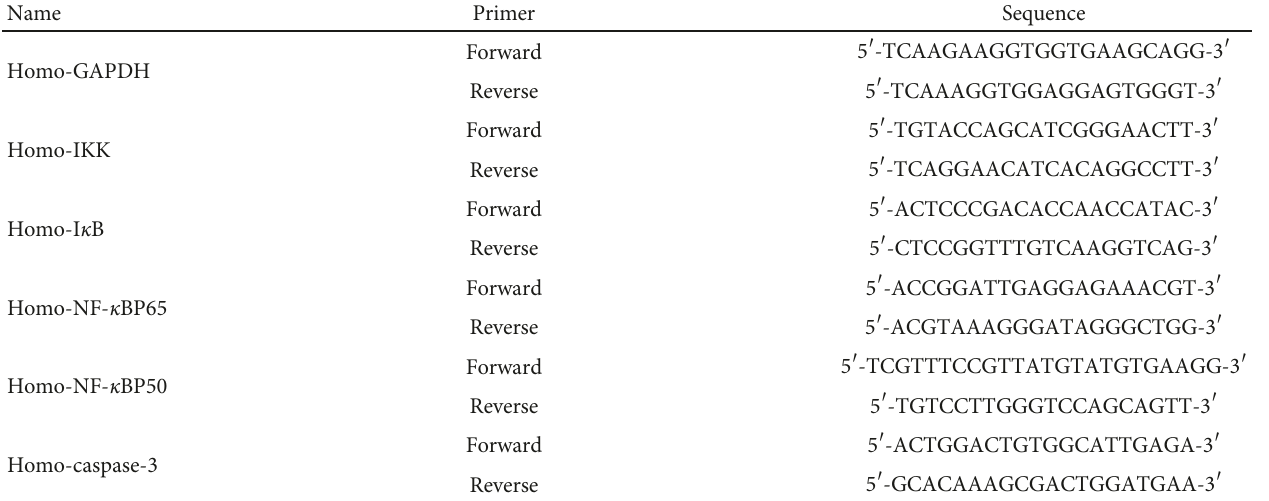
Table 1: Primer of caspase-3 and NF- κ B-related factor.